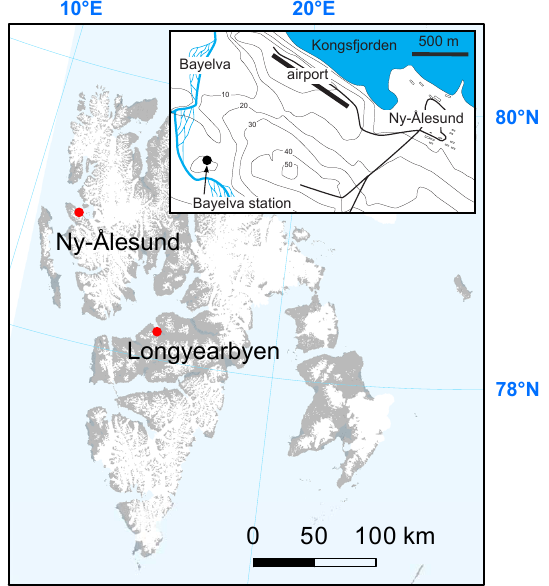
Fig. 1. Map of Svalbard with the location of Ny-Ålesund. The inset shows the area around Ny-Ålesund with the location of the Bayelva station (bold lines: roads; thin lines: 10m contour